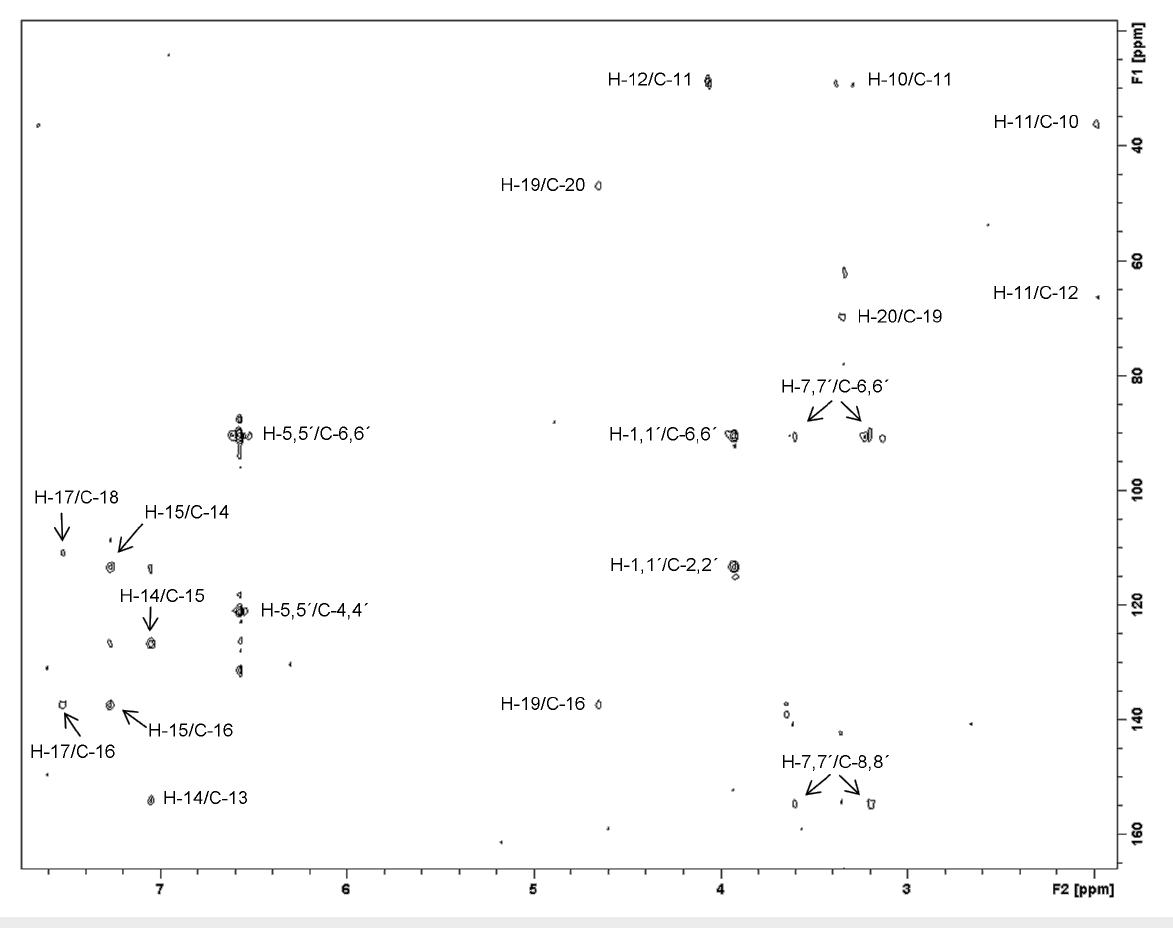
Figure 3: 1,1-ADEQUATE spectrum of 14-debromo-11-deoxyfistularin-3 ( 1 ).